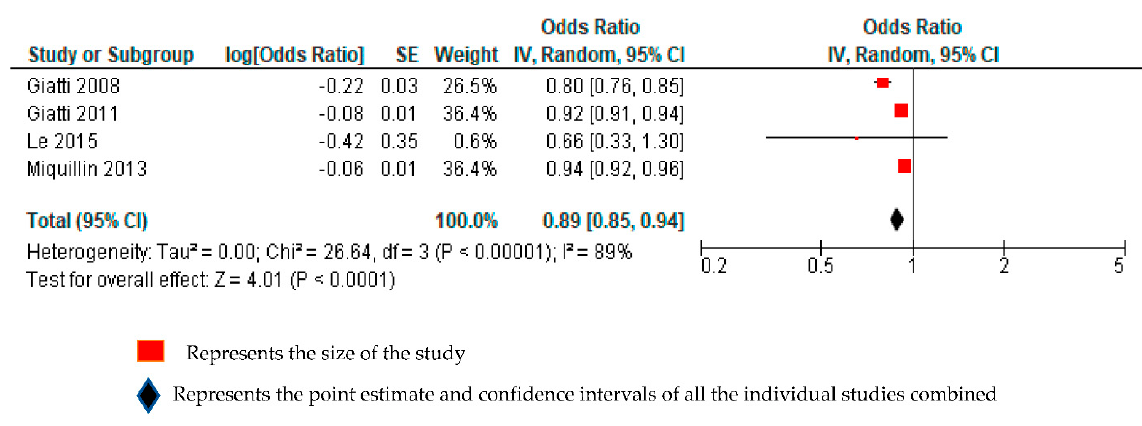
Figure 2. Forest plot assessing any health services use among informal economy workers, compared with formal economy workers.